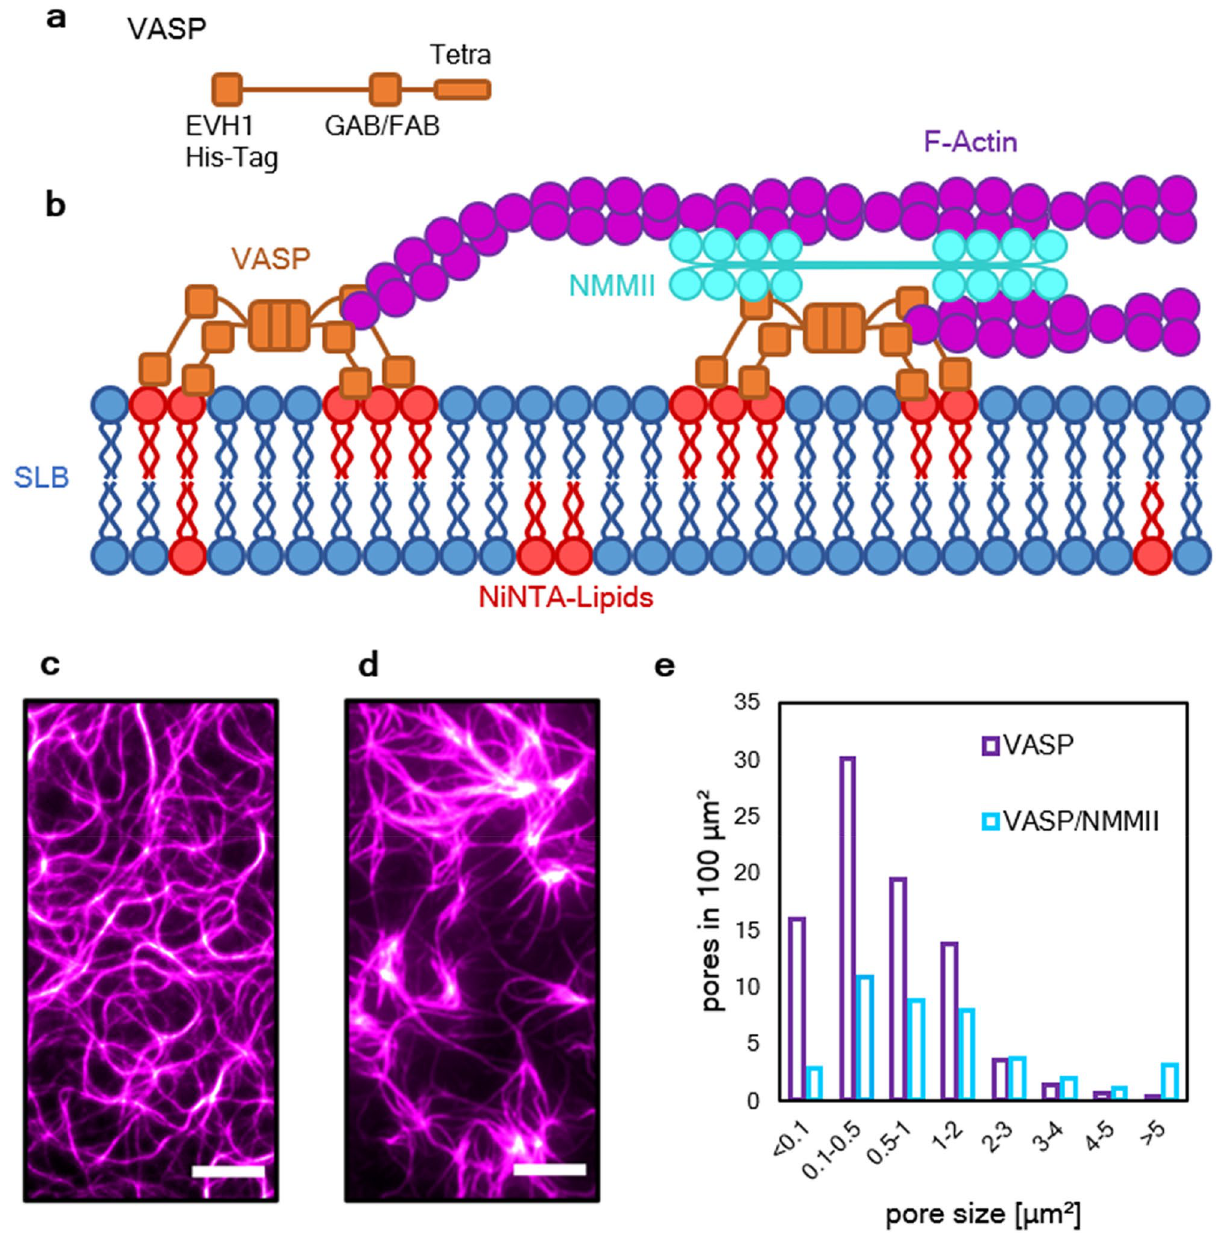
Figure 2. NMMII introduces a novel network phenotype on actin networks anchored to supported lipid bilayers by Ena/VASP. ( a) A graphical representation of the employed VASP construct is shown to highlight the relevant domains. The N-terminal EVH1 domain is functionalized with a 6xHis-Tag to enable association of VASP with the Ni-NTA lipids. GAB and FAB mark the localization of the G-actin and F-actin binding domains of VASP. Tetra represents the tetramerization domain. ( b) Illustration of the experimental setup. VASP (orange) added to the supported lipid bilayer (blue) in an initial step allows binding to the fraction of 2.5% Ni-NTA functionalized lipids (red). A polymerization solution containing actin (magenta) with or without NMMII (cyan) was added. Here, VASP was able to anchor and bundle elongating filaments. NMMII was introduced to study the effect of the motor within the bundled network. ( c) Actin network polymerized on VASP-functionalized lipid bilayers imaged by TIRF microscopy. ( d) Here, the network was polymerized in the presence of NMMII. Both images were taken 20 min after the start of the polymerization reaction. Scale bars = 5 µm. e Histogram of the pore sizes in both network types in an area of 100 µm 2 . In the presence of NMMII, the network displays larger pores and less smaller pores in the range of < 0.1 to 2 µm 2 compared to the network phenotype without